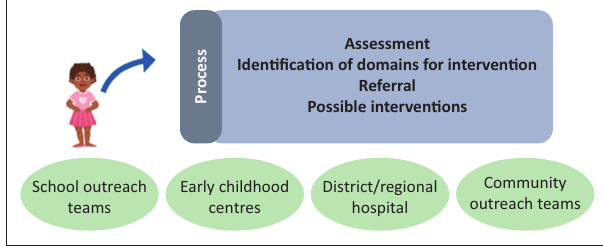
FIGURE 2 : Process within the intervention